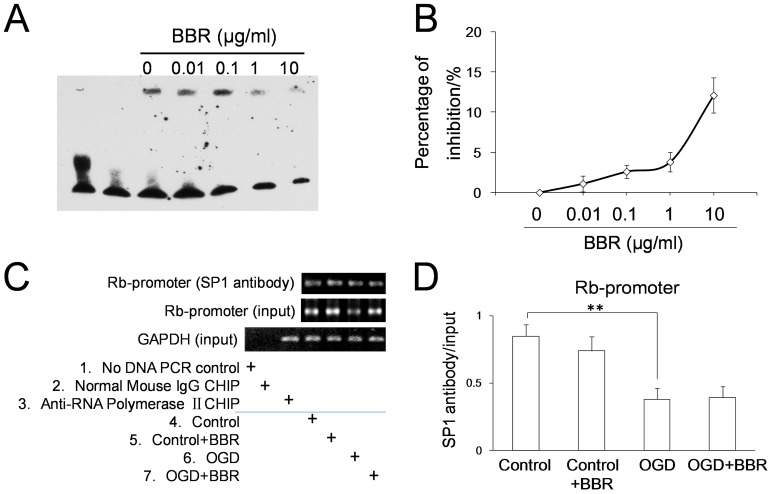
Effects of berberine (BBR) on the combination of SP1 protein with the GC box in RB1 promoter.(A) Image was taken by using EMSA. (B) Suppressive curve of BBR on the combination between SP1 protein and GC box. (C) PCR detection of the GC box-containing DNA fragment of the RB1 promoter bound by SP1 protein in living cells using ChIP. (D) The quantitative analysis of the GC box-containing DNA fragment of the RB1 promoter combined by SP1 detected using real-time PCR. BBR was 0.5 µg/ml. Data are presented as mean ± S.D. of three independent experiments (n = 3). **P<0.01.